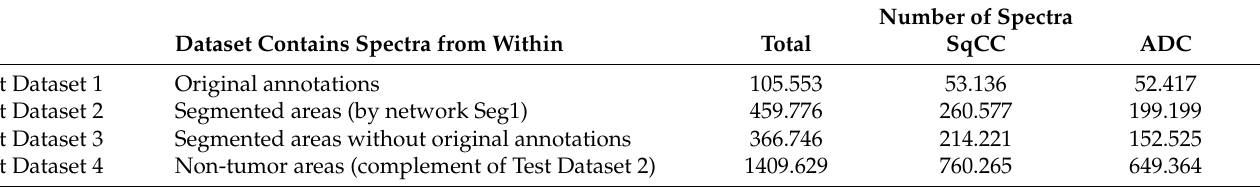
Table 2. MALDI MSI test datasets and their respective numbers of spectra. All four test datasets were based on the 16 test